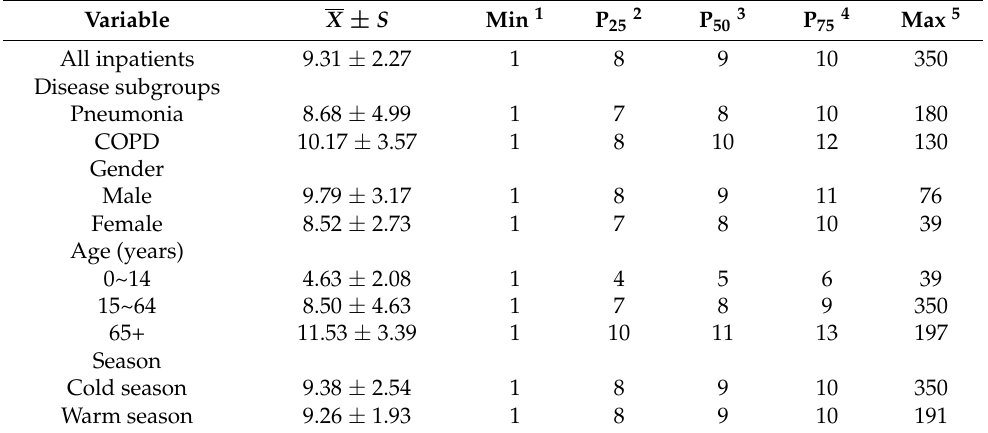
Table 6. Basic information for the period of 2015–2019 for the length of stay for respiratory